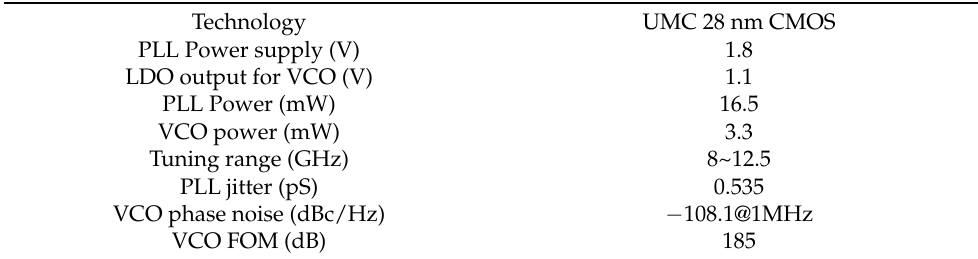
Table 2. Performance summary of LC PLL and LC